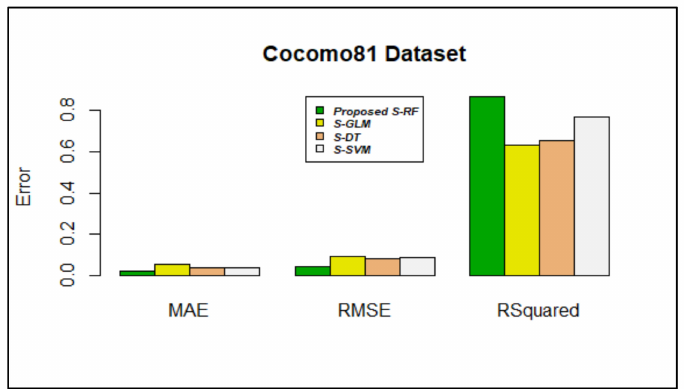
Figure 9. Error rate vs. Stacking models in Cocomo81